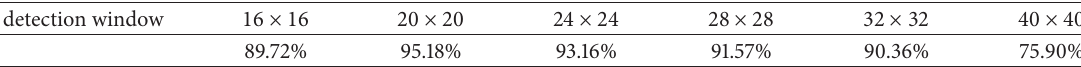
Figure 17: (a) Positive logo samples. (b) Negative logo samples. Table 1: Impact of detection window size on detection accuracy rate.